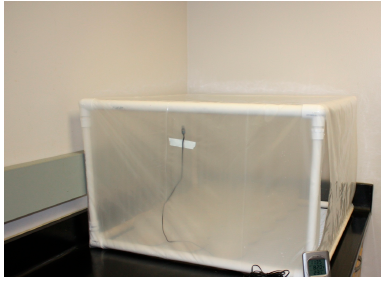
Figure 3. Humidified test chamber for conducting Nylanderia fulva bait bioassays. The chamber consists of a polyvinyl chloride (PVC) frame (1.5 × 1.5 × 1.5 m) covered with plastic sheeting. A data logger recorded temperature and humidity within the chamber. The bottom of the chamber contains a water filled pan that is covered by a plastic grid. The individual bioassay arenas are placed atop the grid. Table 2. Insecticide baits tested for acceptance and efficacy against Nylanderia fulva in laboratory